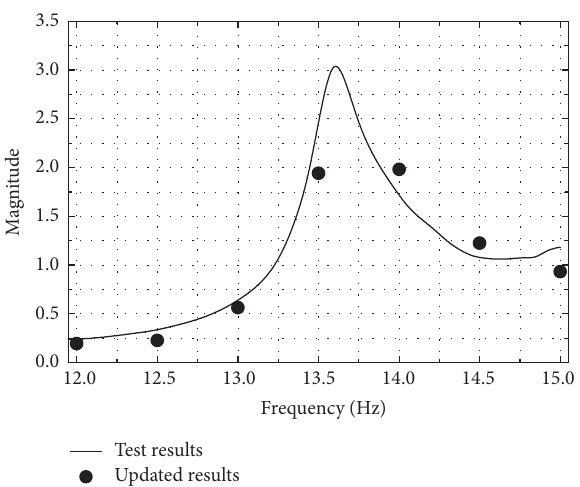
Figure 14: Measured and updated FRFs with 8N